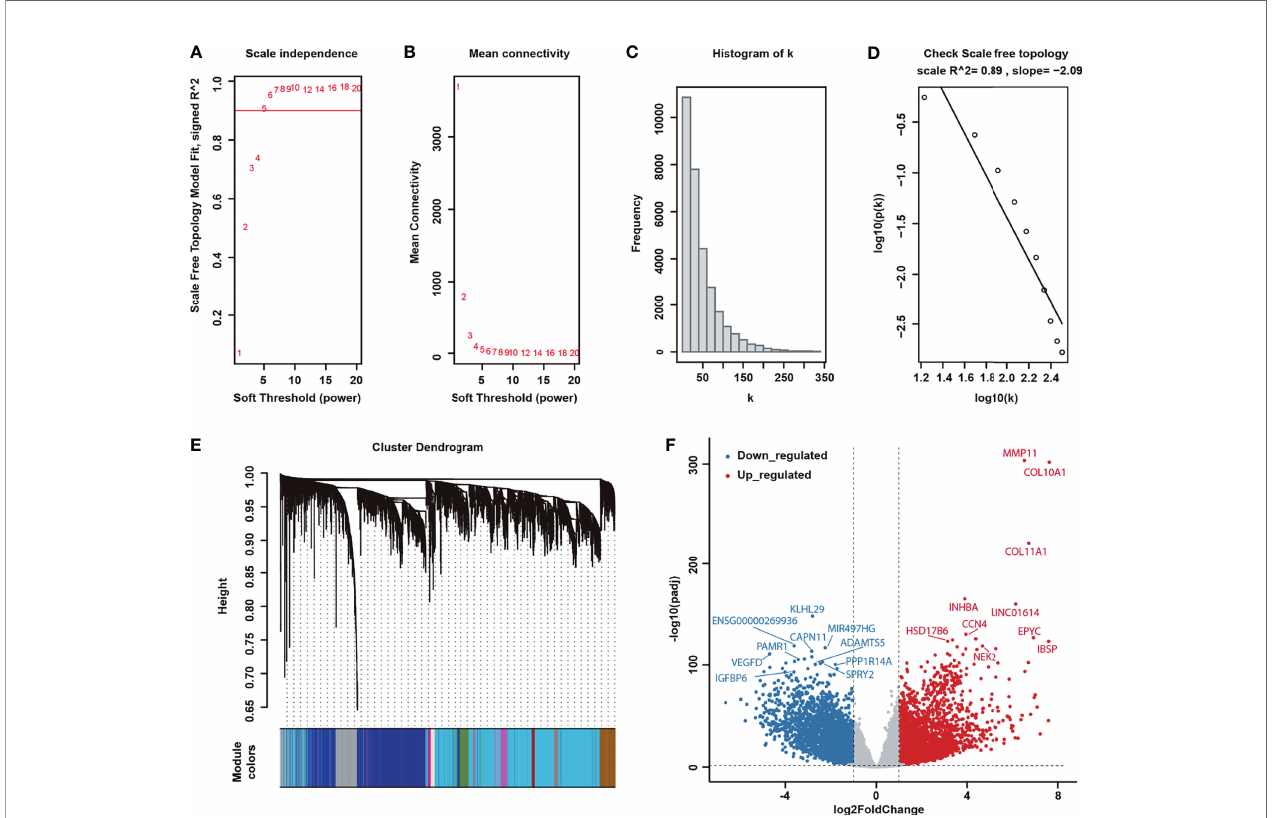
FIGURE 1 | Determination of co-expression modules and differentially expressed genes in the weighted gene co-expression network analysis (WGCNA). (A) Scale- free index analysis of varying threshold powers ( b ). (B) The mean connectivity analysis of various soft-threshold powers. (C) The frequency of network connectivity (K). (D) Checking the scale-free topology when b is equal to 5. The x-axis represents the logarithm of whole network connectivity, and the y-axis shows the logarithm of the corresponding frequency distribution. The distribution follows an approximately straight line (R 2 = 0.89), termed scale-free topology. (E) Modules mined by the WGCNA algorithm. (F) Differentially expressed genes of BRCA. An adjusted P -value (Bonferroni, p-adj ) of less than 0.01 and log2 |fold change (FC)| of at least 1 were considered to suggest signi fi cantly differential